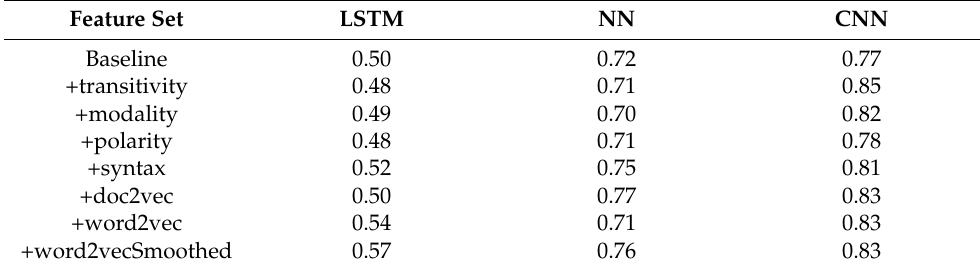
Table 6. Classification of solutions from non-solutions using deep learning networks by training data